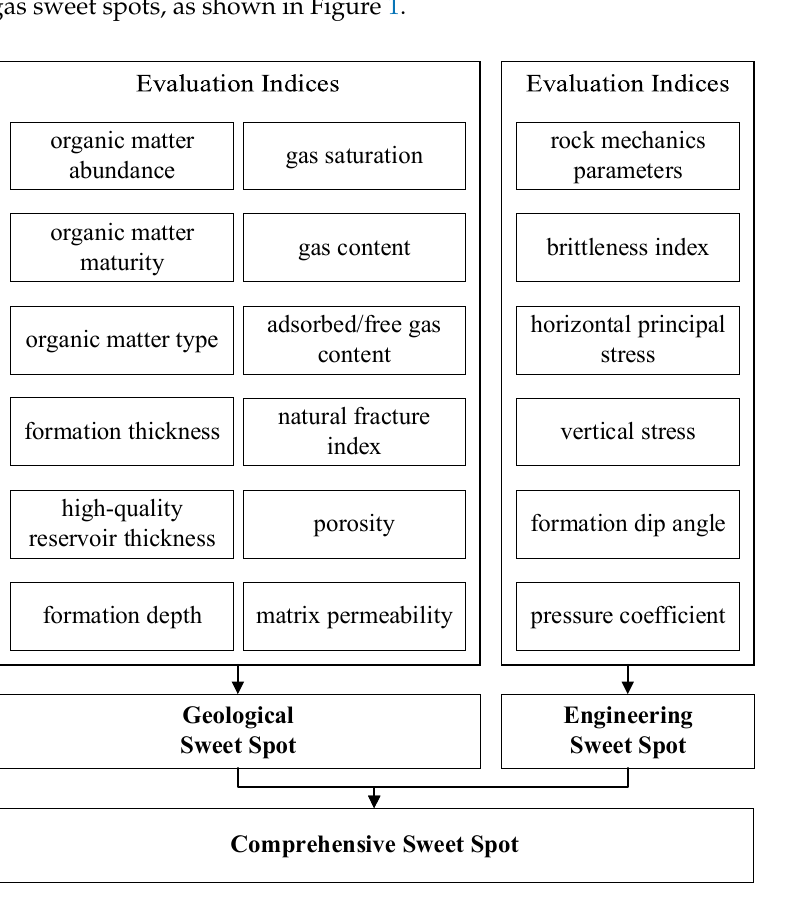
Figure 1. Evaluation index system and evaluation indices of shale gas sweet spots.